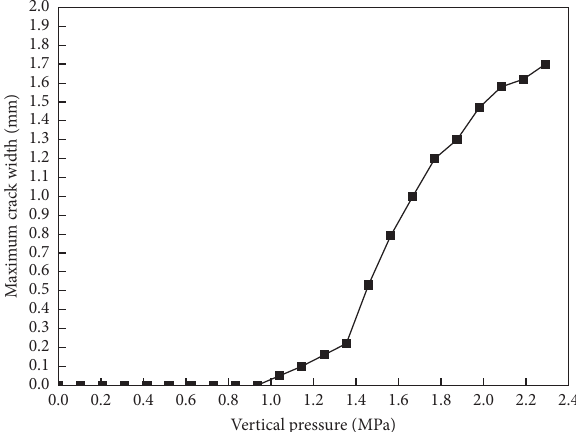
Figure 7: The maximum crack width